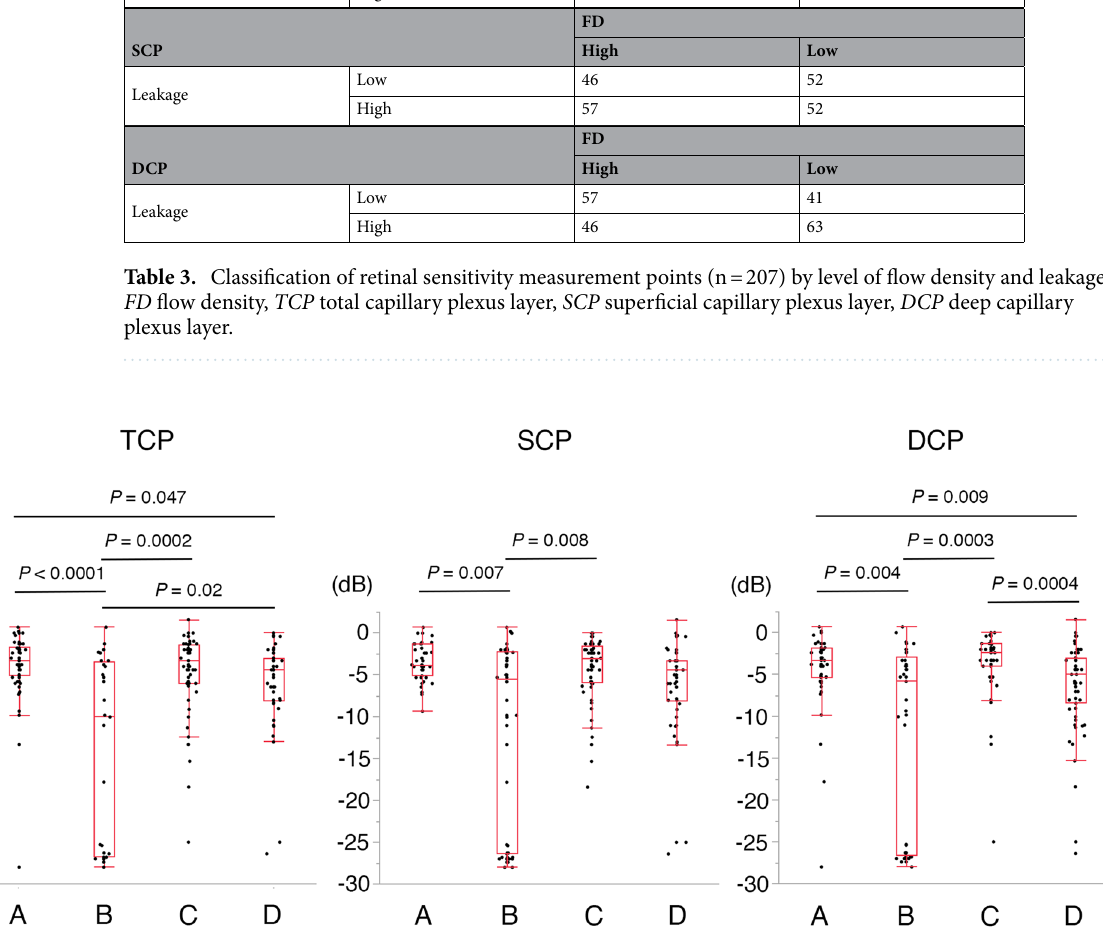
Figure 2. Comparison of reductions in retinal sensitivity among the four groups. All RS measurement points were classified into four groups according to FD and vascular leakage. Group A: high FD and low leakage, Group B: low FD and low leakage, Group C: high FD and high leakage, Group D: high FD and high leakage. The Steel–Dwass test was used for statistical analyses. FD flow density, RS retinal